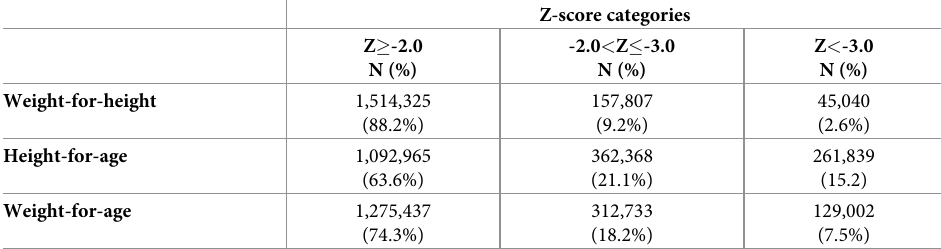
Table 2. Children classified according to normal and abnormal growth or body